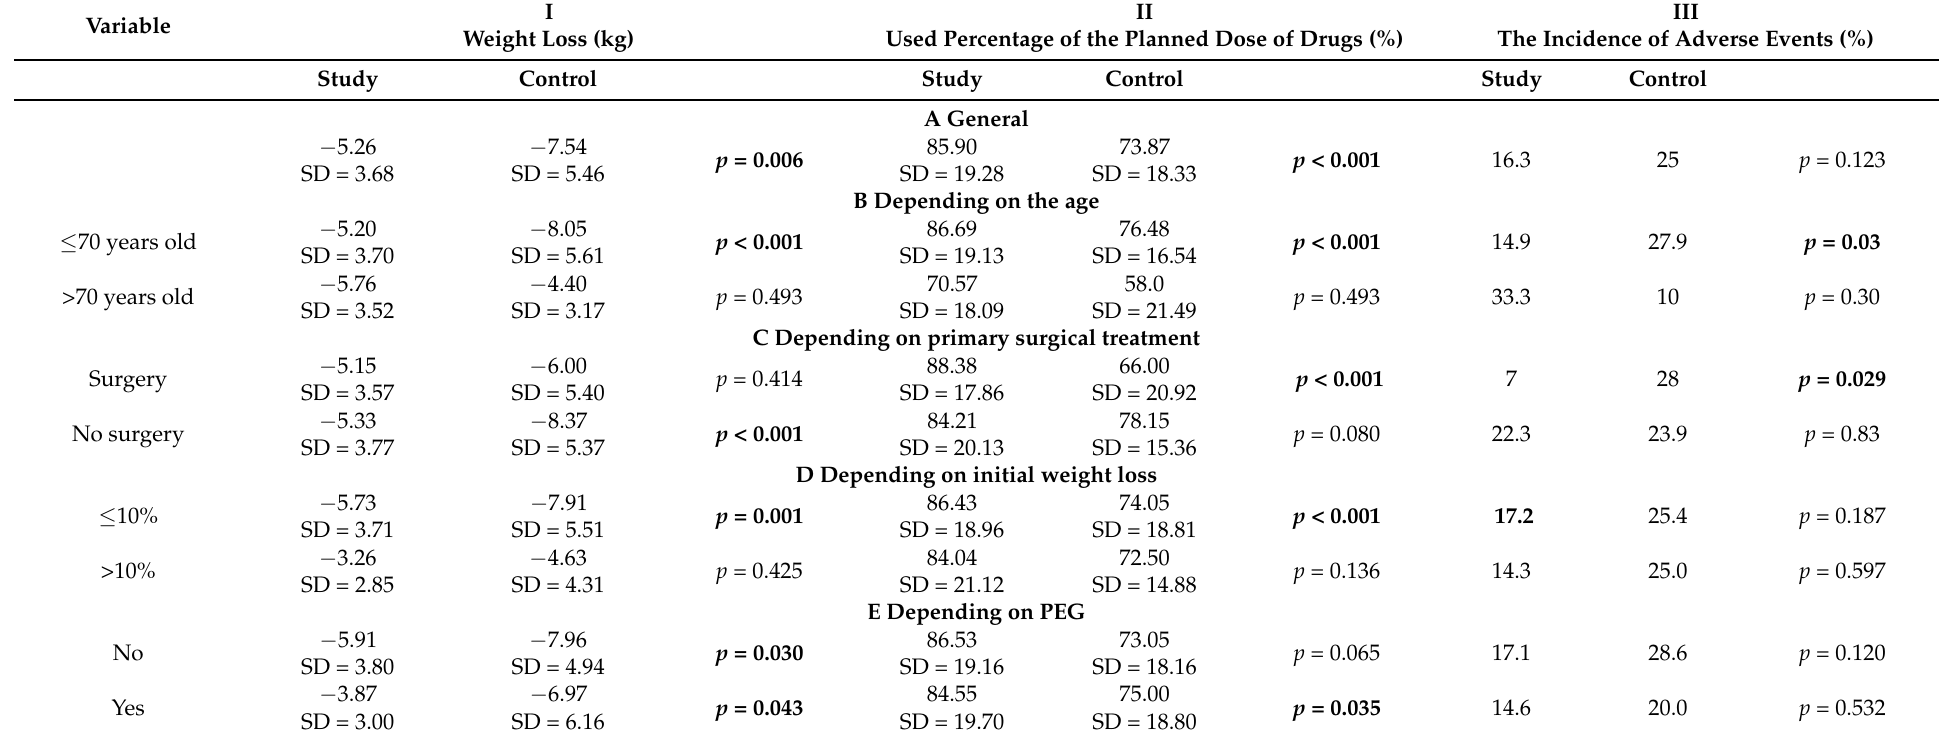
p -value in the table = p -value of post hoc analysis (for ANOVA— p -value for simple effects); Bold-statistically